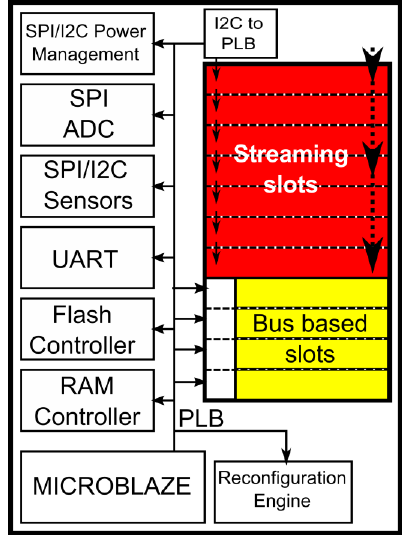
Figure 4. FPGA inner blocks. Virtual